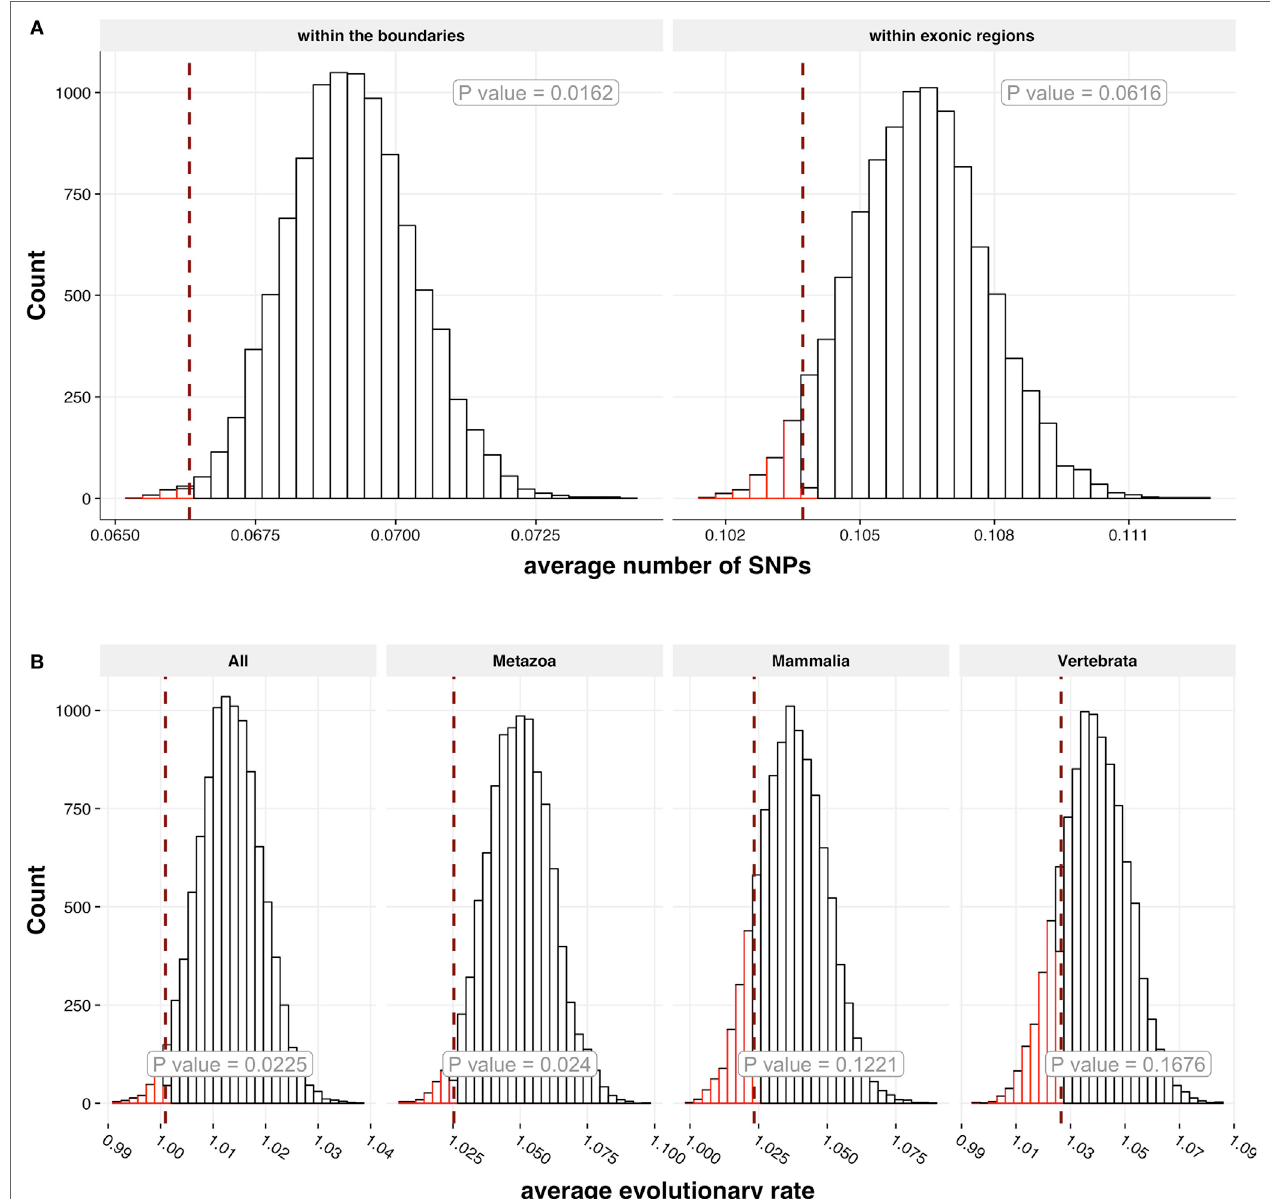
FigUre 6 | Genetic polymorphisms and evolutionary conservation of APECED autoantigens. (a) Association of autoantigens with single nucleotide polymorphisms (SNPs). Two SNP categories were analyzed: the number of SNPs (i) within the boundaries of a gene (left histogram) and (ii) within exon regions of a gene (right histogram). For both histograms 10,000 randomly sampled groups of Protoarray proteins (genes) were generated with the size equal to the size of positive autoantigen group. On the x -axis the average number of SNPs is shown. The red dashed line shows the number of SNPs in positive autoantigen group. The p -value for each category of SNPs has been calculated in order to estimate the significance of a difference between randomly sampled groups and positive group. The autoantigen group has lower mean normalized SNP count, then it would be expected on average for the genes encoding proteins on Protoarray. (B) Evolutionary conservation rate. The four histograms that show distribution of average evolution rates for 10,000 randomly sampled groups of Protoarray genes were generated with the size equal to the size of positive autoantigen group. Each histogram represents a comparison of positive autoantigen group with ortholog genes in different evolutionary categories ( all, metazoa , mammalia , or vertebrata species). On the x -axis the average evolutionary rate is shown. The red dashed line represents an average evolutionary rate of positive autoantigen group. Computed p -values indicate that autoantigens are on average more conserved in categories all and metazoa than the rest of the genes encoding proteins on